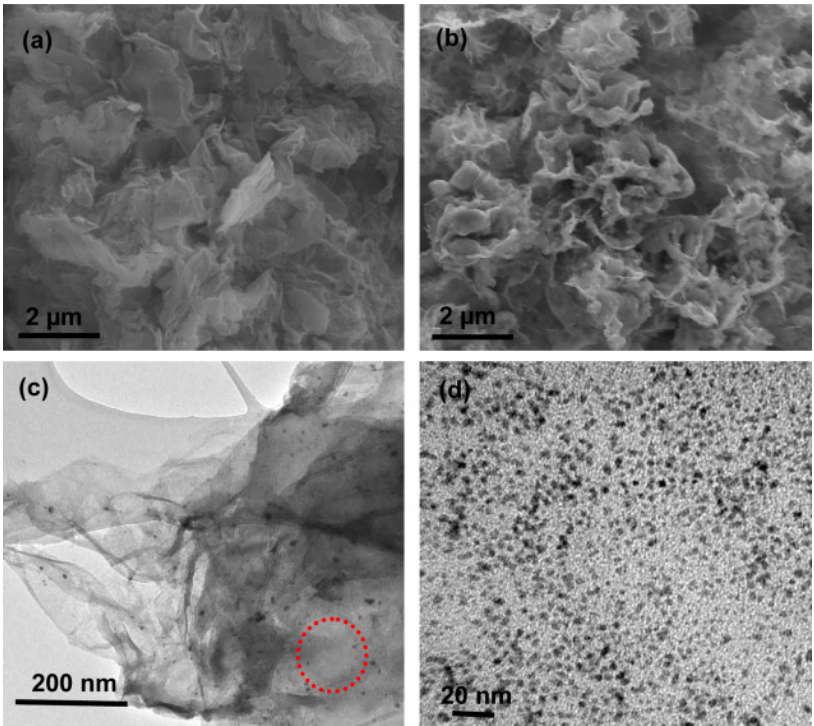
Figure 14. ( a ) SEM image of GNPs before incorporated with MnO2; ( b ) SEM image of MnO 2 -GNP composite; ( c ) TEM image of MnO 2 -GNP composite at low magnification; ( d ) TEM image of the area highlighted by the dashed cycle in ( c ) at high magnification. Reprinted with permission from Ref. [52]. 2011,